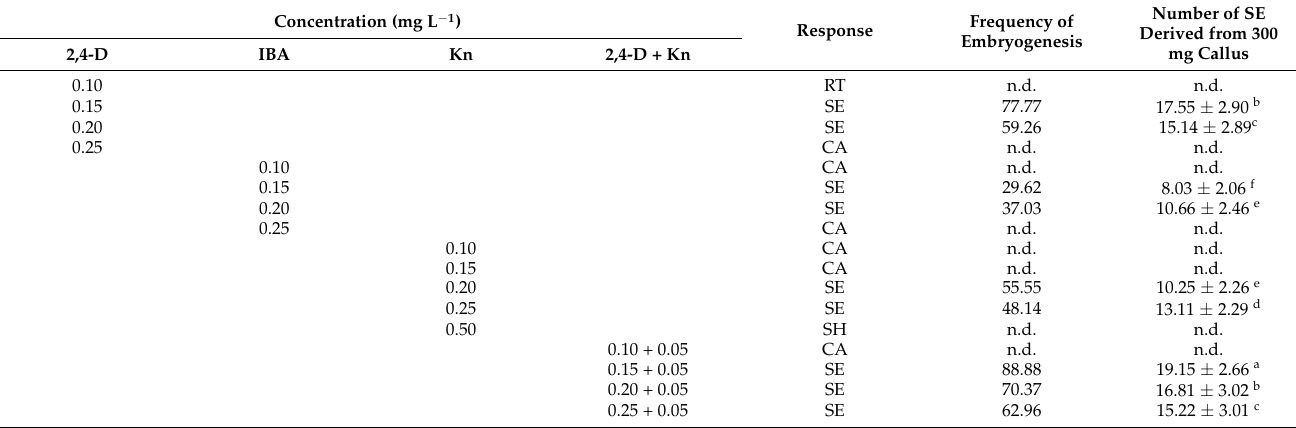
Table 1. Effect of PGRs on somatic embryogenesis in leaf-derived 8-week calli of V. canescens after 6 weeks of culture.